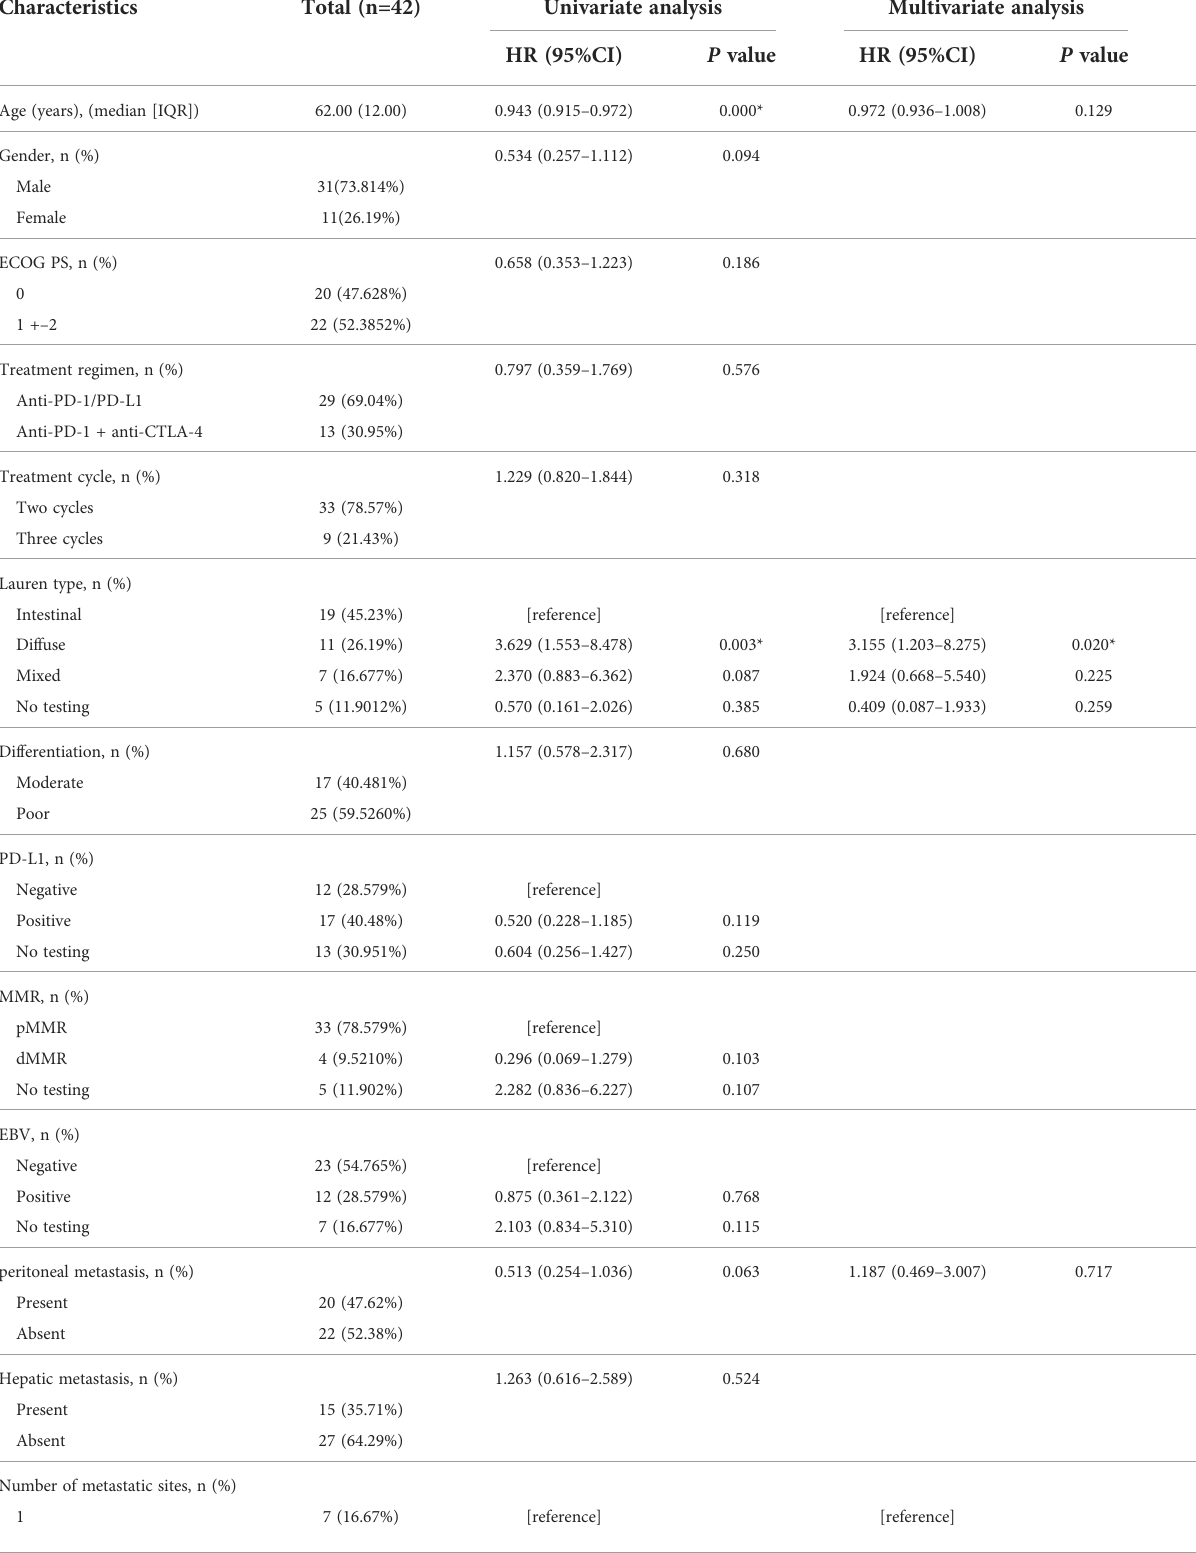
TABLE 1 The clinicopathological characteristics of the included